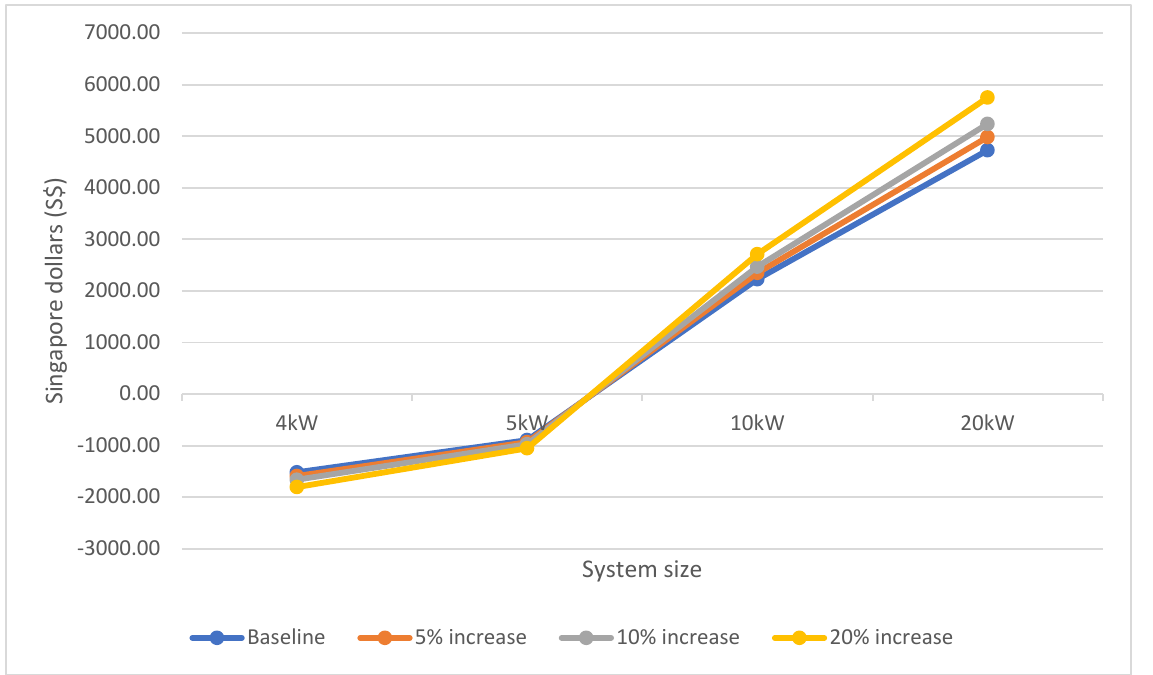
Figure 4. Changes to cost savings to the changes in electricity tariffs.